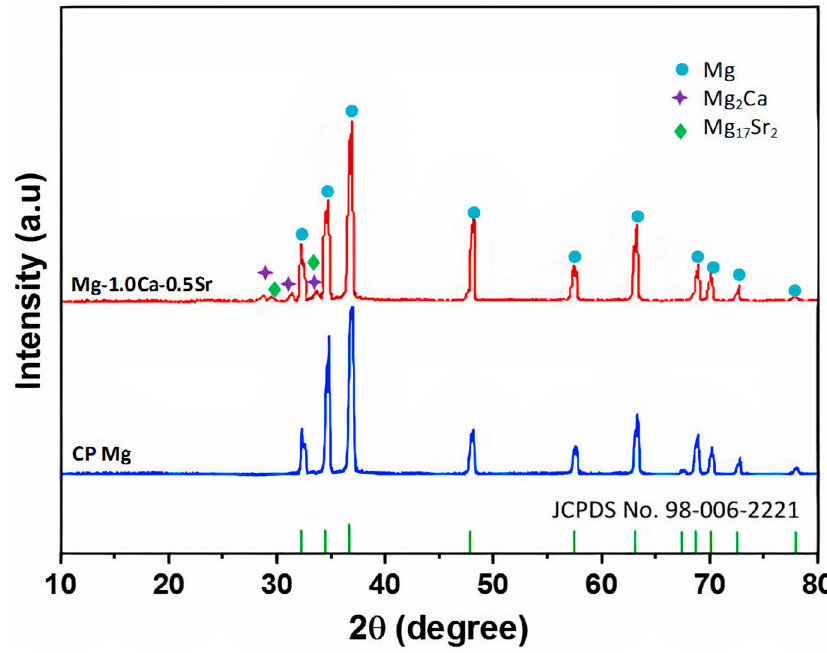
Figure 3. The XRD spectra of as-cast CP Mg and Mg-1.0Ca-0.5Sr alloy.